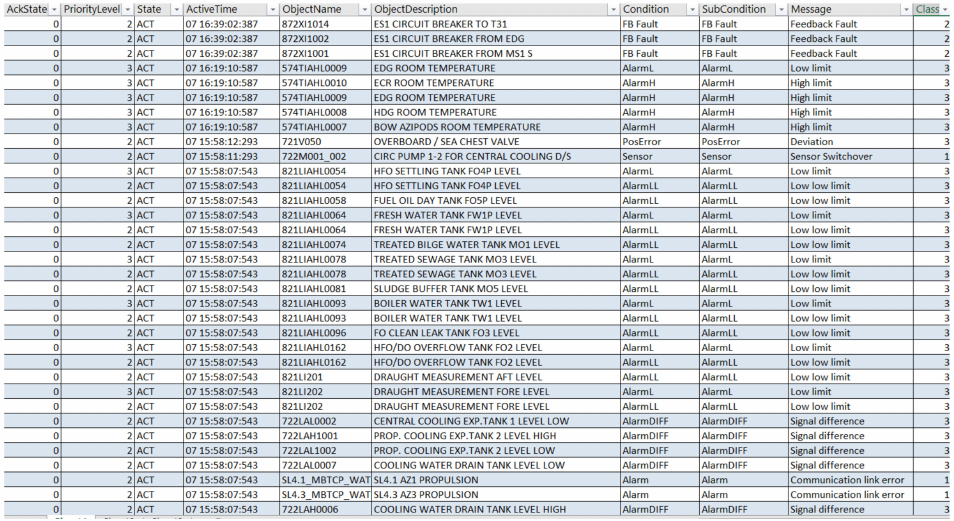
Figure 11. Screenshot of the exported data